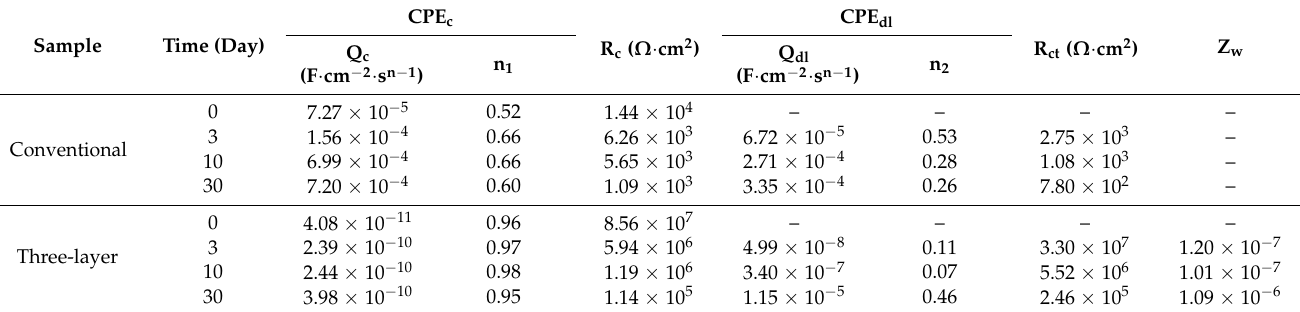
Figure 10. The equivalent electrical circuits (EEC). Table 6. Values of impedance parameters extracted from the equivalent models.